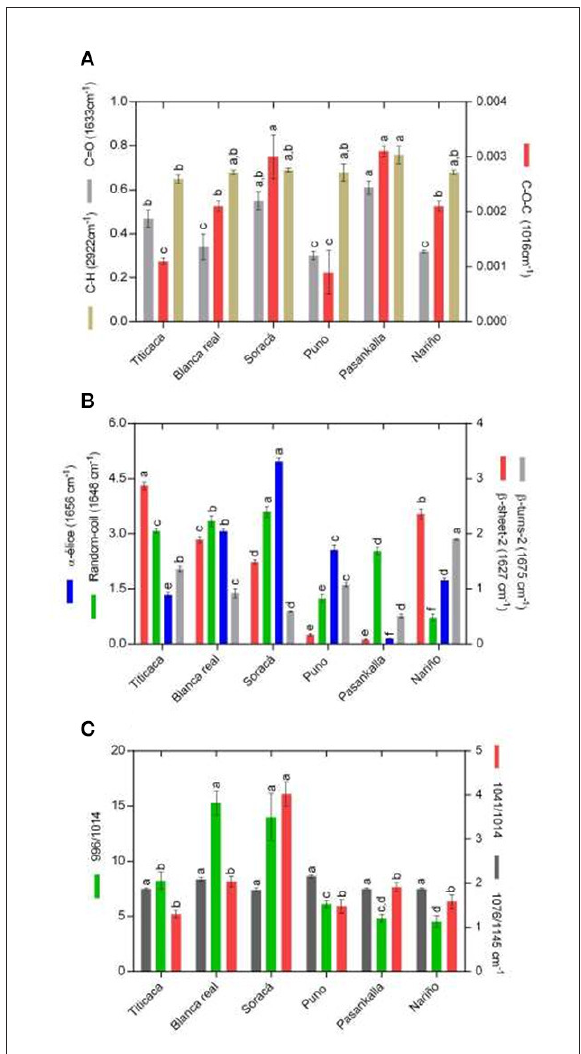
FIGURE4 Summary of FTIR results of the analysis of quinoa cultivars. The average with different letters shows significant difference ( p < 0.05). In (A) , the results are reported with respect to the normalized intensity, while in (B,C) , the results are presented with respect to the area under the curve of the peaks of